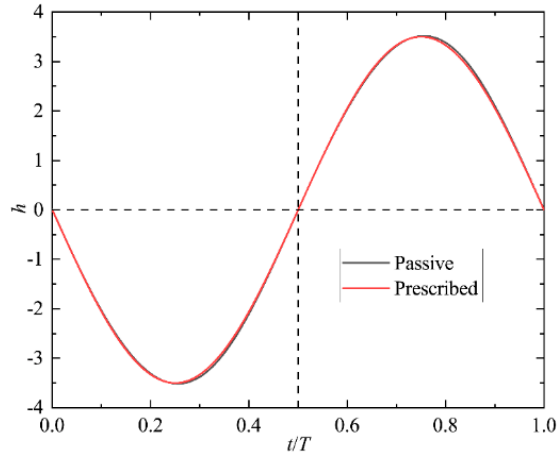
Figure 15. Motion curves of the prescribed and passive motions under maximum efficiency condi- tions.